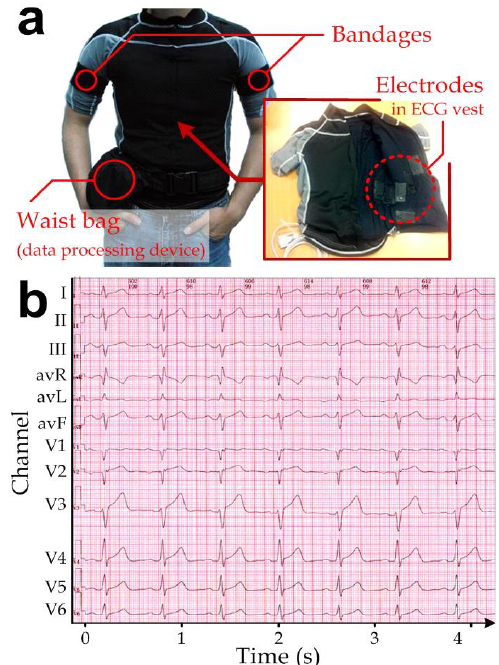
Figure 7. ( a ) ECG vest embedded with the microengineered conductive-PDMS electrodes (inset) on the inner surface of the clothing. Bandages on the arms were used to fix the electrodes LA and RA in positions. A waist bag contained circuitry for data acquisition, signal processing and wireless transmission; ( b ) Representative 12-lead ECG measured by the ECG